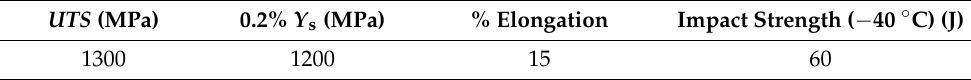
Table 2. Mechanical properties of CLARM HBR steel alloy